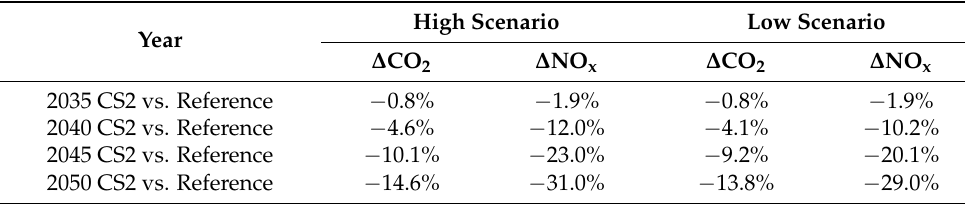
Table 6. Emission results of the Low and High Scenarios for 2035 to 2050.